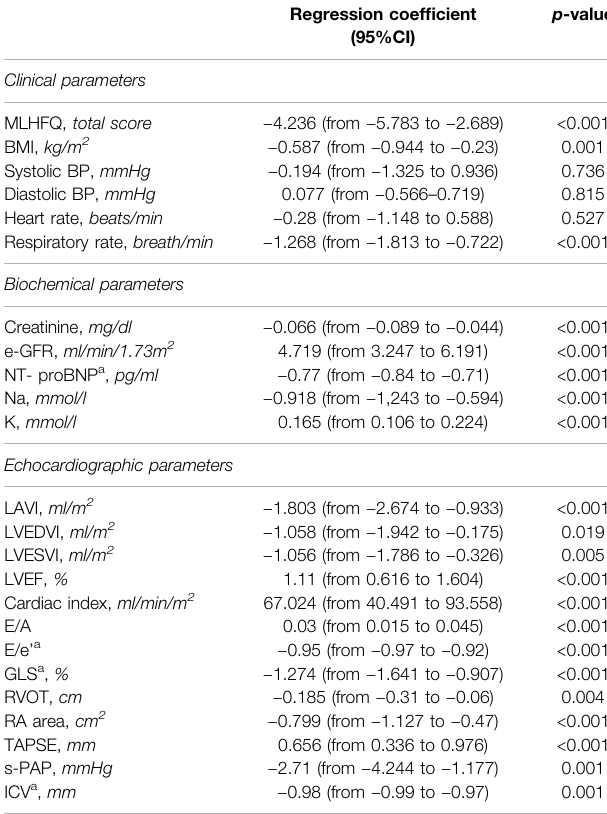
TABLE 3 | Univariate linear mixed models of study variables over